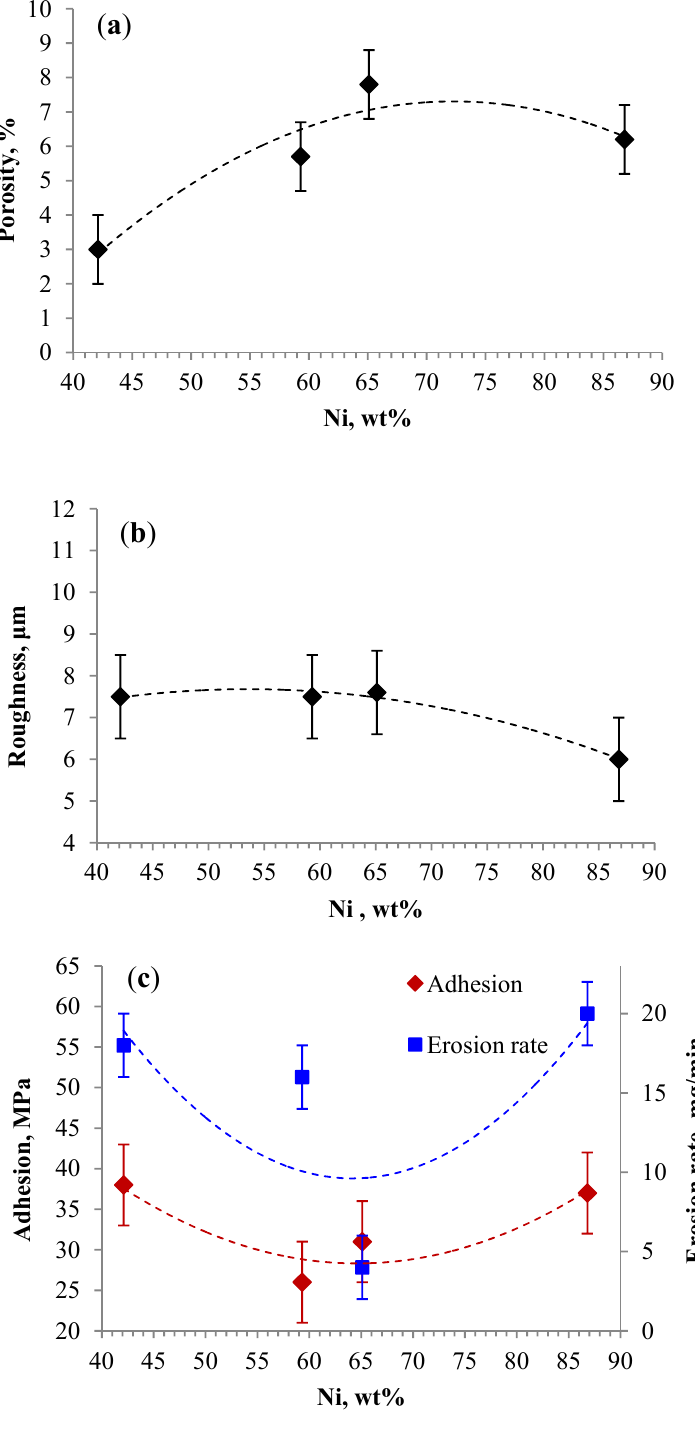
Figure 10. Influence of the initial charge composition treatment of the powder on the ( a ) porosity; ( b ) roughness and ( c ) adhesion strength and erosion